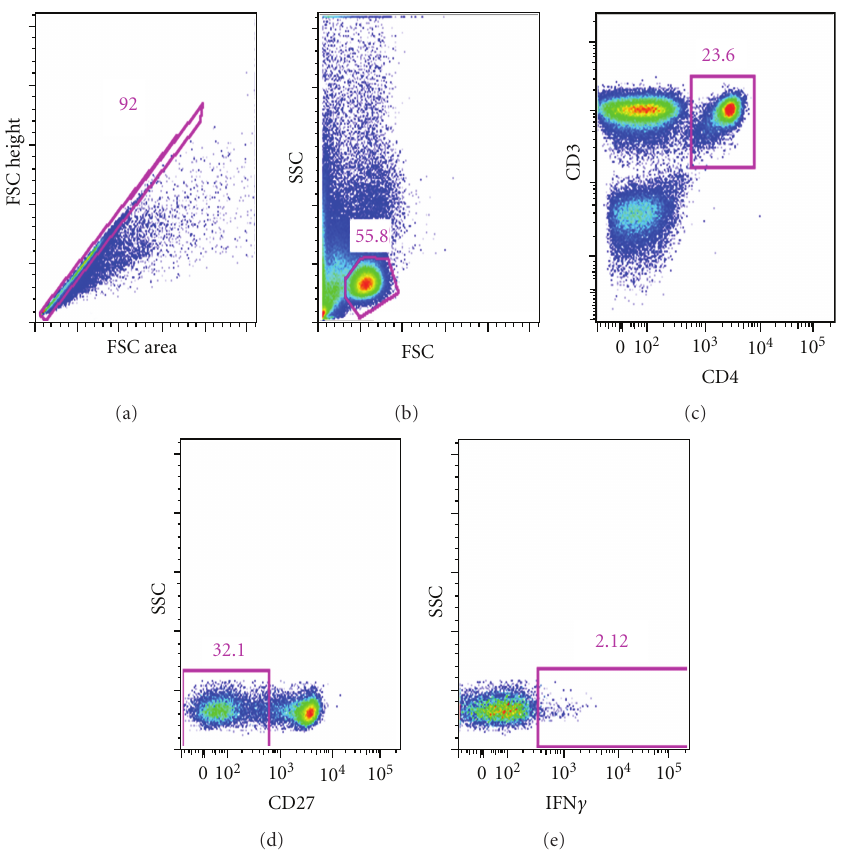
Figure 2: Flow cytometry dot plots showing gamma interferon production from the CD27 − CD4+ memory T lymphocyte population. (a) shows exclusion of doublets by gating cells with proportional forward scatter area ( x -axis) against forward scatter height ( y -axis). (b) shows gating of total lymphocytes according to forward scatter ( x -axis) and side scatter ( y -axis). (c) shows the CD3+ and CD4+ coexpressing lymphocytes. (d) comprises only CD3+ CD4+ lymphocytes and shows the CD27 − (CD27 on x-axis and SSC on y-axis) CD3+ CD4+ lymphocytes. (e) shows the percentage of IFN γ secreting memory CD27 − CD4+ memory T lymphocytes. The position of the gate was determined in the unstimulated control tube and copied into the stimulated tubes.